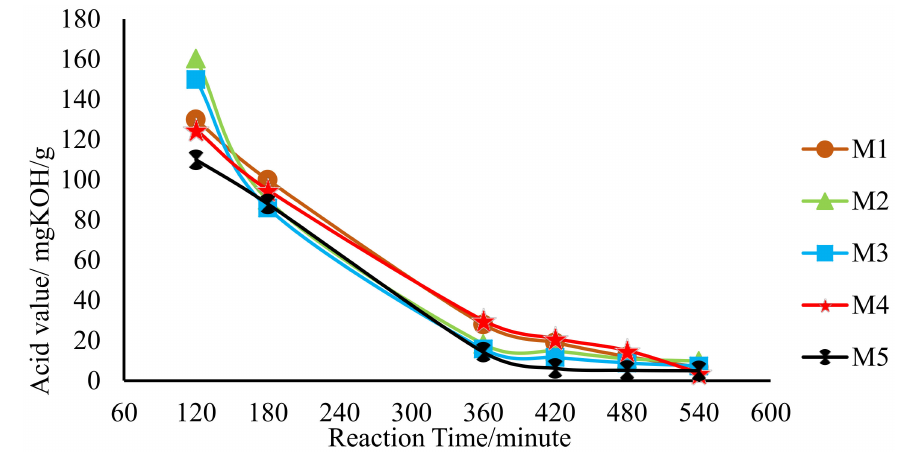
Figure 1. Acid value as function of reaction time.